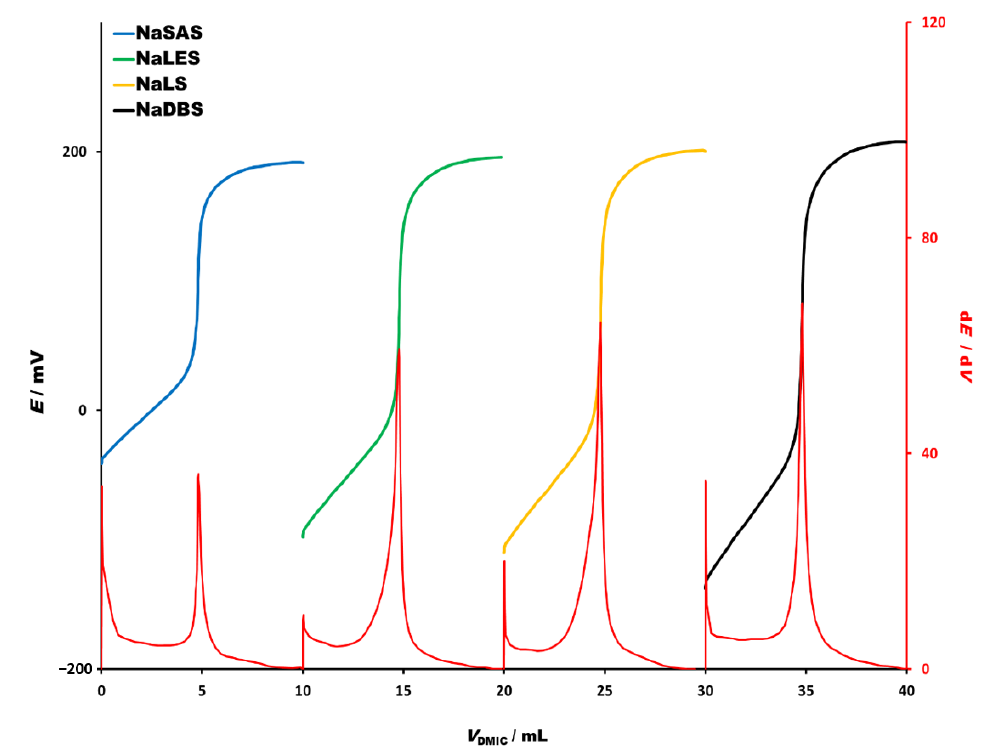
Figure 6. Potentiometric titration curves of technical grade anionic surfactants (4 × 10 − 3 M) with DMIC (4 × 10 − 3 M) as a titrant and the DHBI-TPB surfactant sensor as an end-point indicator. Corresponding first derivatives are presented in red lines below titration curves. The titration curves and their first derivatives are rearranged for the sake of clarity in the following order: SAS (blue line), LES (green line), SDS (yellow line), DBS (black line).